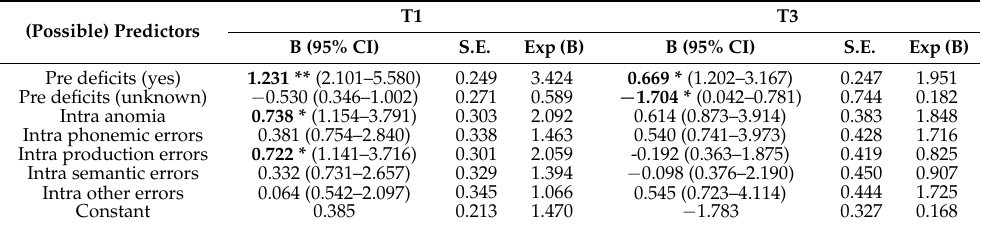
Table 5. Binary logistic regression models of predictors for language outcome at T1 ( n = 589) and T3 (T3, n = 456).